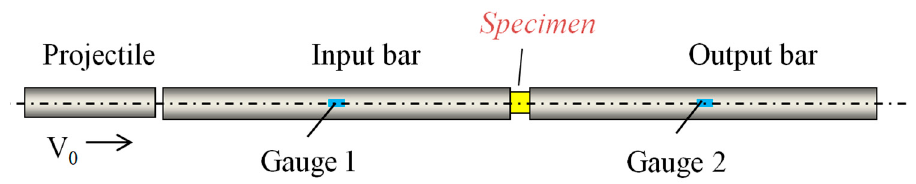
Figure 1. Schematic description of the split Hopkinson pressure bars (SHPBs) for dynamic compression.